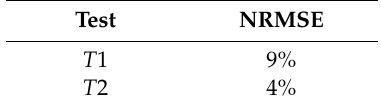
Table 3. Results of the Geolocation Correction.